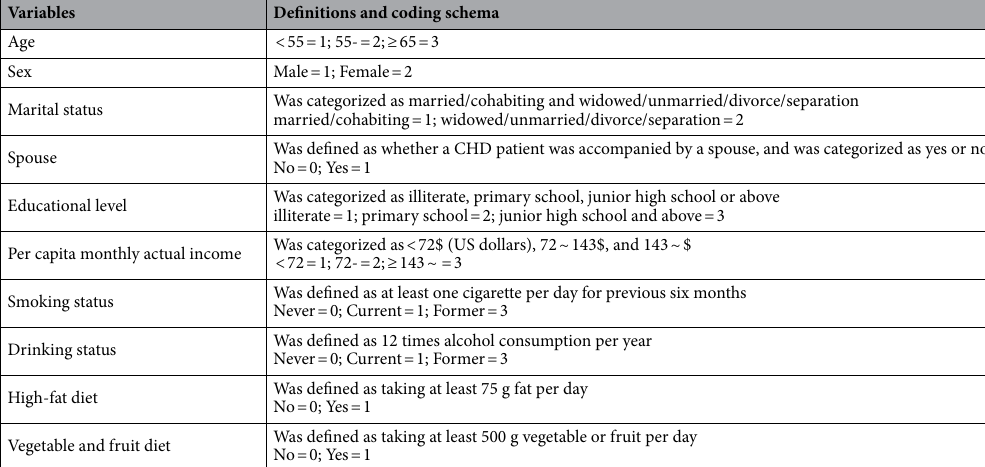
Table 1. Definitions and coding schema for patients’ sociodemographic variables.